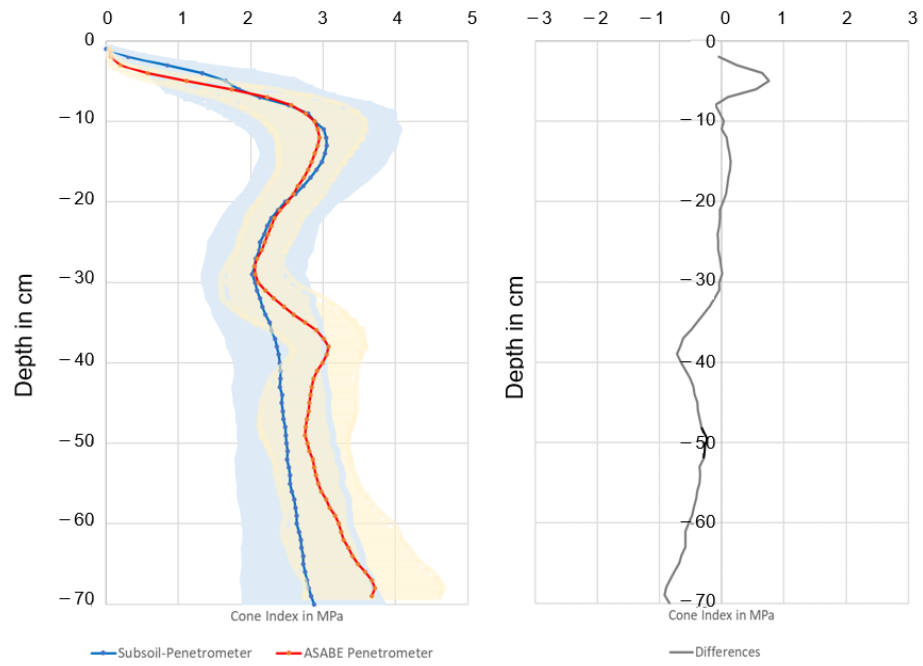
Figure 6. Comparison of the cone index and respective standard deviation of the SSP and a conven- tional penetrometer (accordant with ASABE standards) on a field ( n = 240) ( left ), and the differences in cone index ( right ).